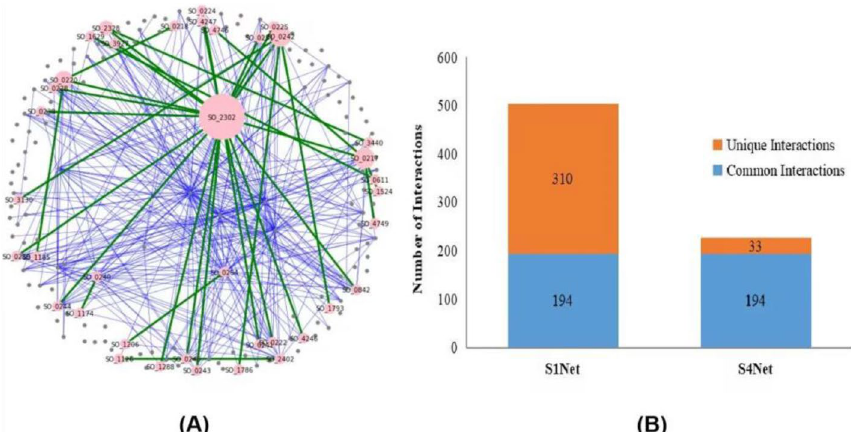
Fig. 5 Changes in interaction in active networks. Notes: A Interaction of S1Net and S4Net. The blue edges in the figure represent the protein– protein interactions that disappeared in the process from S1Net to S4Net, the green edges represent the protein–protein interactions that are newly added in the process from S1net to S4net, and the common protein–protein interactions between S1Net and S4Net are not shown in the figure. The pink nodes are the nodes related to the newly added edges. The size of the node is determined by the degree value of the node. B Veen plot of interaction data in S1Net and S4Net